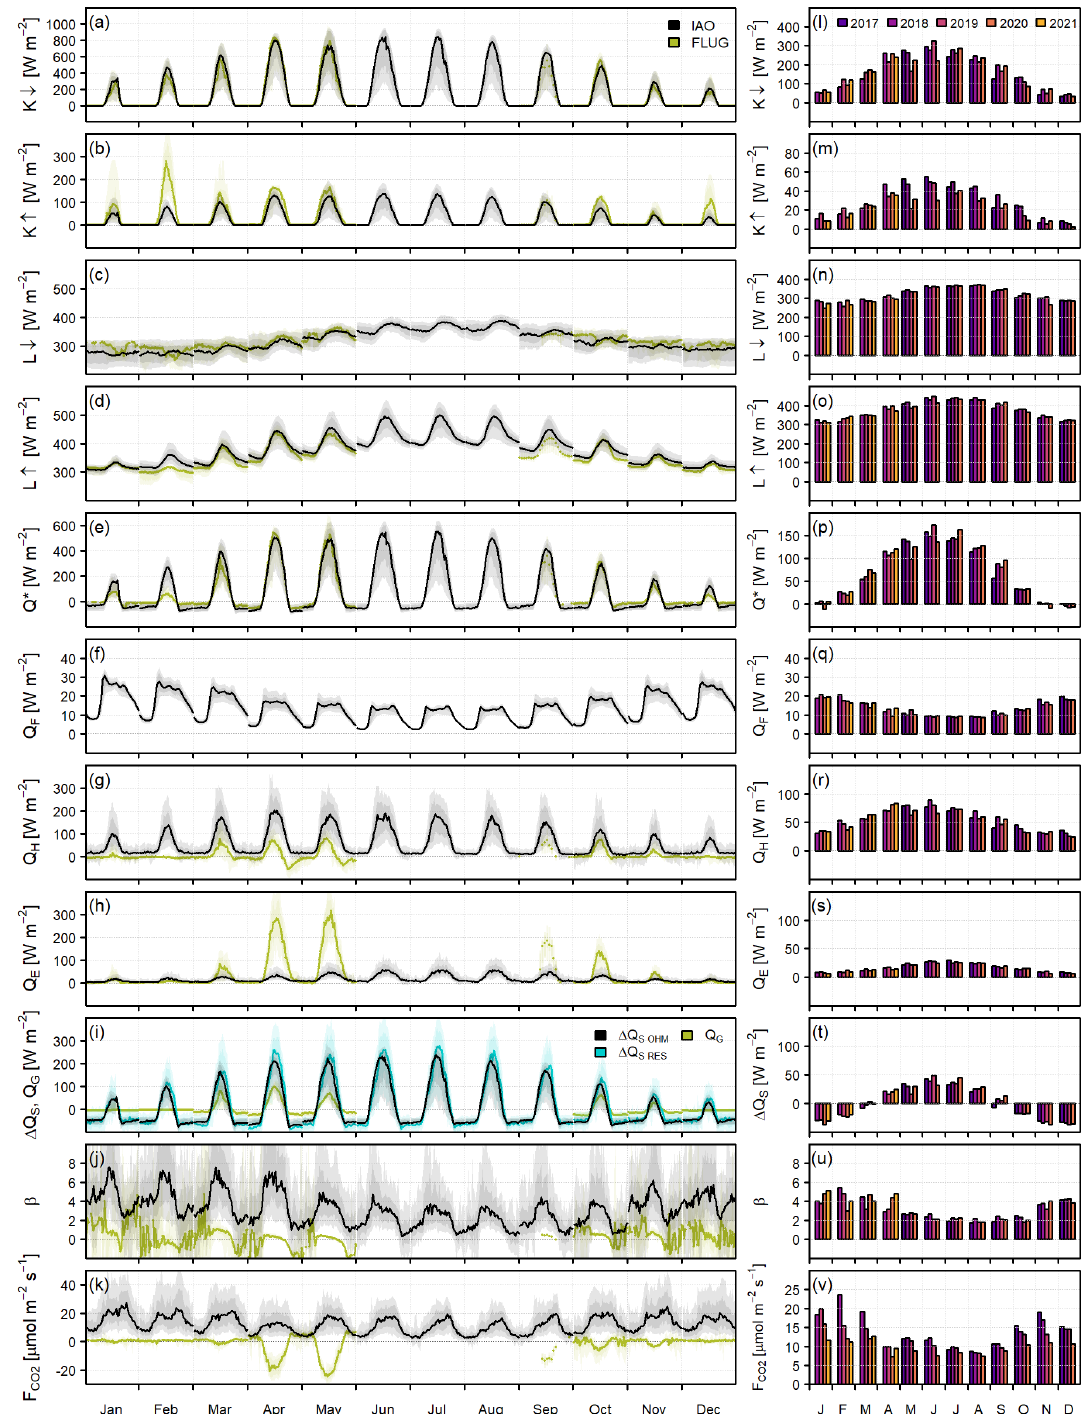
Figure 12. (a–k) Monthly median diurnal cycles (lines), interquartile ranges (dark shading) and 10–90th percentiles (light shading) of radiative fluxes, energy balance terms and carbon dioxide fluxes. (a) Incoming shortwave radiation. (b) Outgoing shortwave radiation. (c) Incoming longwave radiation. (d) Outgoing longwave radiation. (e) Net all-wave radiation. (f) Anthropogenic heat flux. (g) Sensible heat flux. (h) Latent heat flux. (i) Storage heat flux. (j) Bowen ratio. (k) Carbon dioxide flux. All available data for IAO and FLUG are shown in black and green, respectively. In panel (i) , the net storage heat flux ( (cid:49)Q S ), estimated using the Objective Hysteresis Model (OHM) and estimated as the energy balance residual (RES), is shown for IAO, and the ground heat flux ( Q G ) is shown for FLUG. (l–v) Bar plots of daily mean fluxes at IAO are separated by month and by year (colours). In panel (t) , the storage heat flux is estimated using OHM. Note the different y -axis